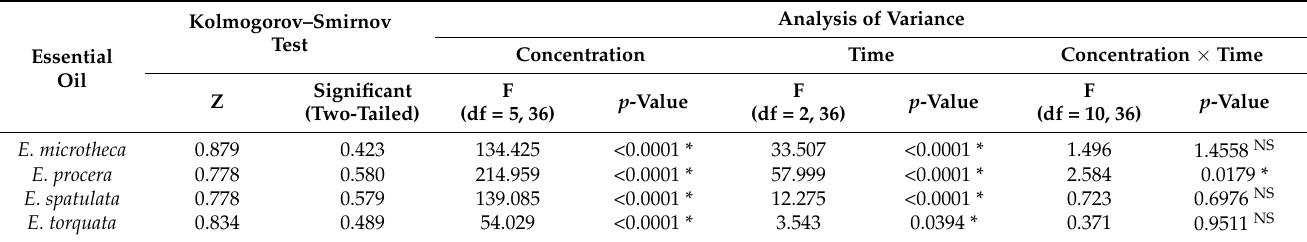
Table 2. The results of the Kolmogorov–Smirnov test and analysis of variance of the data obtained from the fumigant toxicity of E. microtheca , E. procera , E. spatulata , and E. torquata essential oils against the adults of Rhyzopertha dominica .